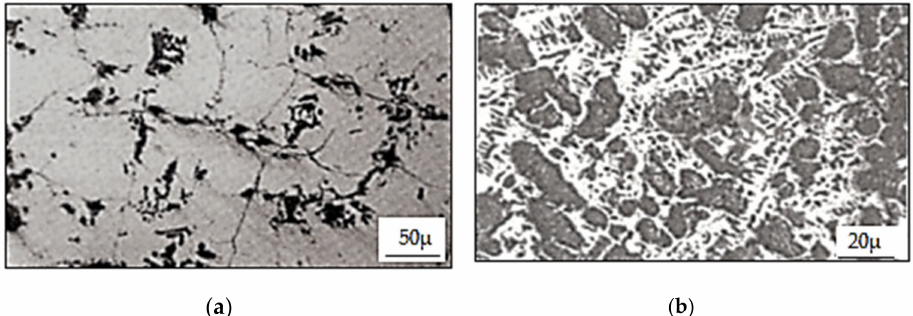
Figure 9. Cross-section through a hardened cast iron cylinder after a campaign: ( a ) without etching, ( b ) with etching (2% Nital)